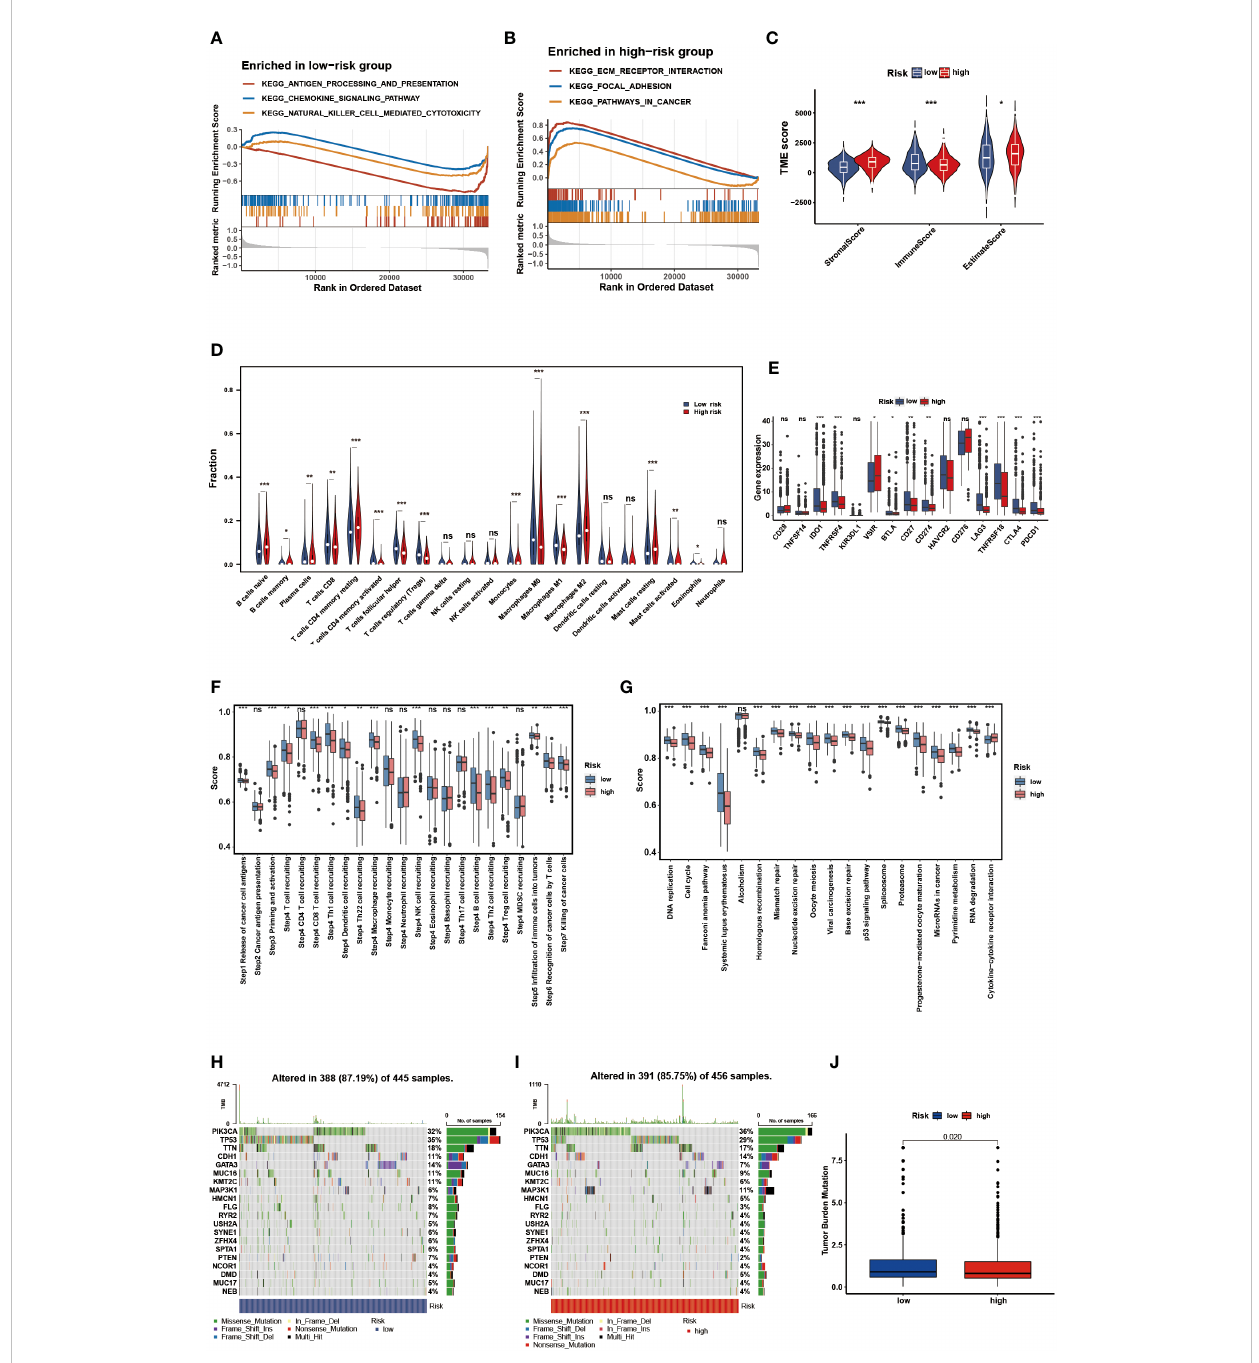
FIGURE 8 Identi fi cation of the immune landscape between the two risk groups. The GSEA of the DEGs. (A) in the low-risk group. (B) in the high-risk group. (C) Comparisons of the stromal, immune and ESTIMATE score in the two risk groups. (D) Comparisons of immunocyte ’ s in fi ltration fractions in the two risk groups. (E) The differential expression of checkpoint genes in the two risk groups. (F) Differences of cancer-immunity cycle scores in the two risk groups. (G) Differences of immune-associated positive signals in the two risk groups. The mutation landscape of the top 20 genes. (H) in the low-risk group. (I) in the high-risk group. (J) Comparisons of TMB in the two risk groups. * p<0.05, ** p<0.01, *** p<0.001, ns